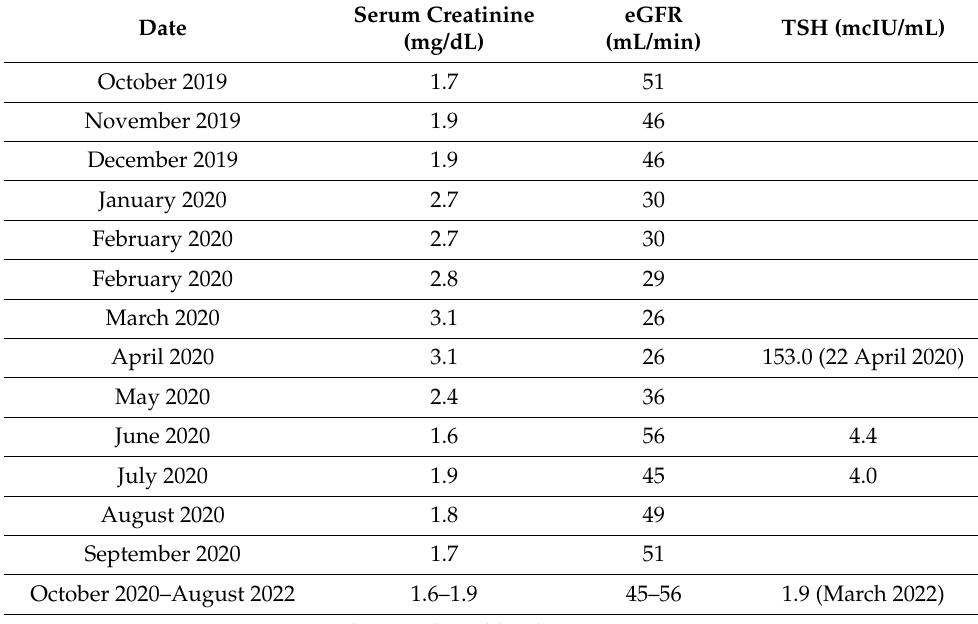
Table 1. Time course of renal and thyroid